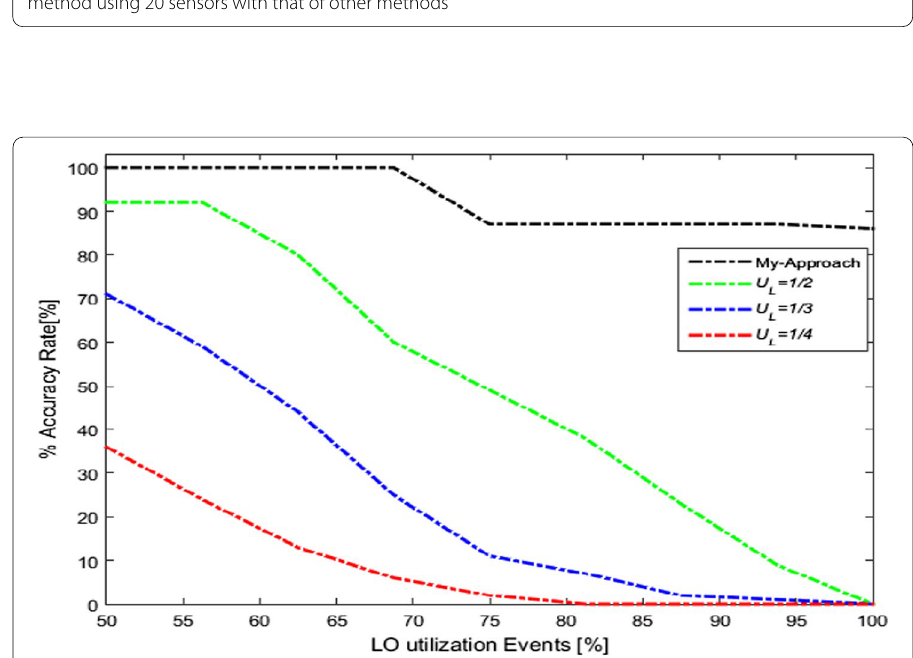
Fig. 6 The accuracy of classifying patients’ health status in the proposed model